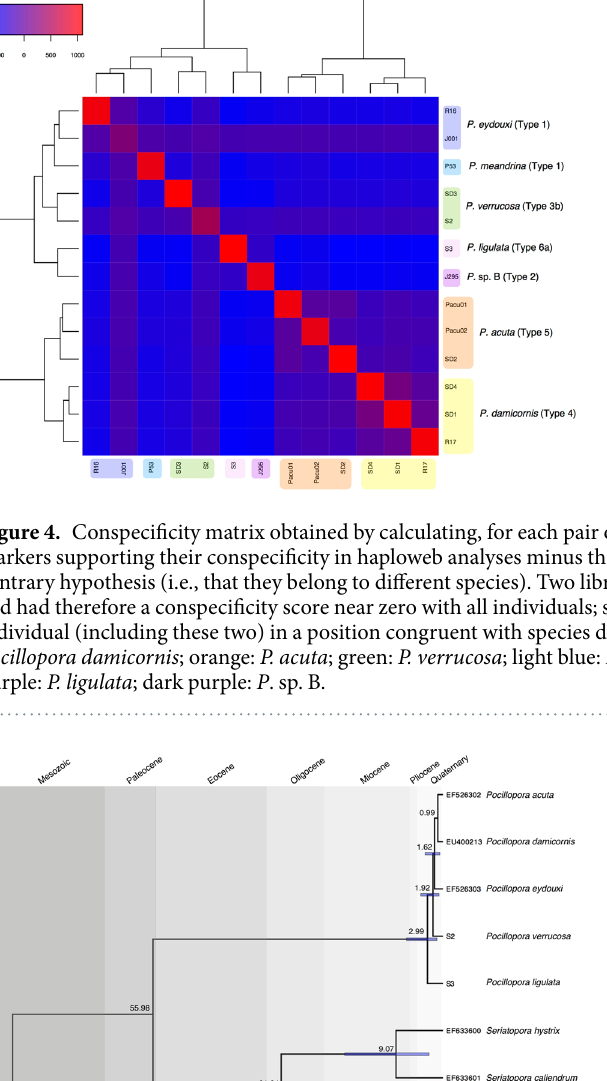
species boundaries within Pocillopora and determine whether previously unrecognized narrow range endemics or cryptic species exist. However, given the striking monophyly of the taxa included here, we predict that future sampling will reveal low level genetic variation within valid nominal species, and do not expect to see evidence of frequent hybridization between any of these species. Combosch and Vollmer 31 reported a lack of monophyly between three morphospecies sampled from the Tropical Eastern Pacific (TEP) using RAD-seq, which contrasts with our findings. Although we do not have extensive sampling of TEP lineages, some of our seven species have broad geographic coverage that includes the TEP. There are three possible reasons for this inconsistency between studies. First, morphological misiden- tification to species is rampant in this genus 2, 9, 11, 12 , and it takes only a single misidentified individual in pooled samples to show mixed signal and bias the results toward introgression, therefore our RAD-seq libraries were all